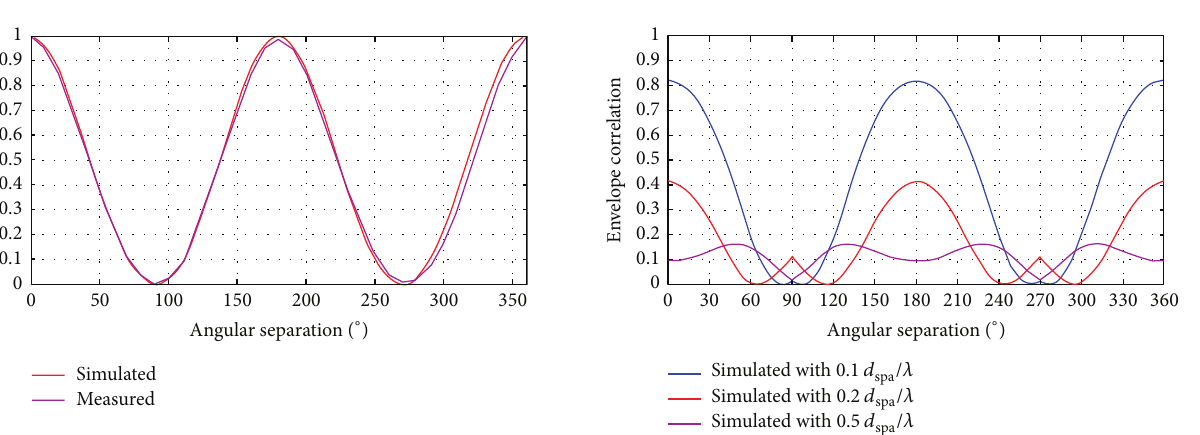
Figure 3: Envelope correlation of a pair of 𝜆/2 dipole antennas as a function of their angular separation. Simulations and measure- ments.